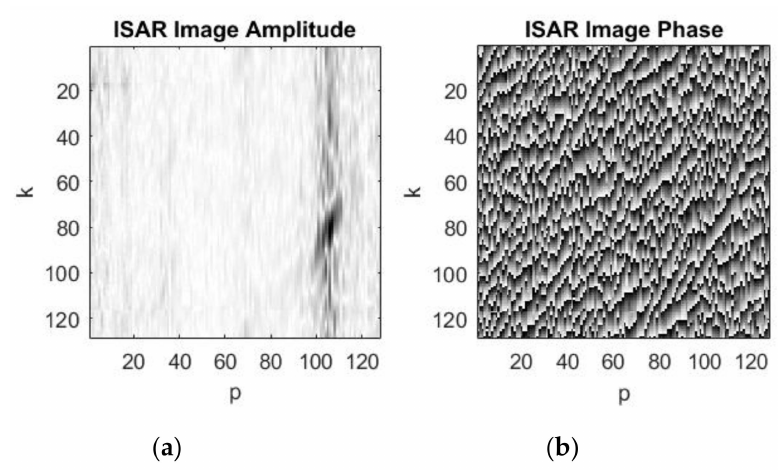
Figure 10. Resulting complex image after 8th additive summation of complex images: ( a ) ISAR image amplitude; ( b ) ISAR image phase.